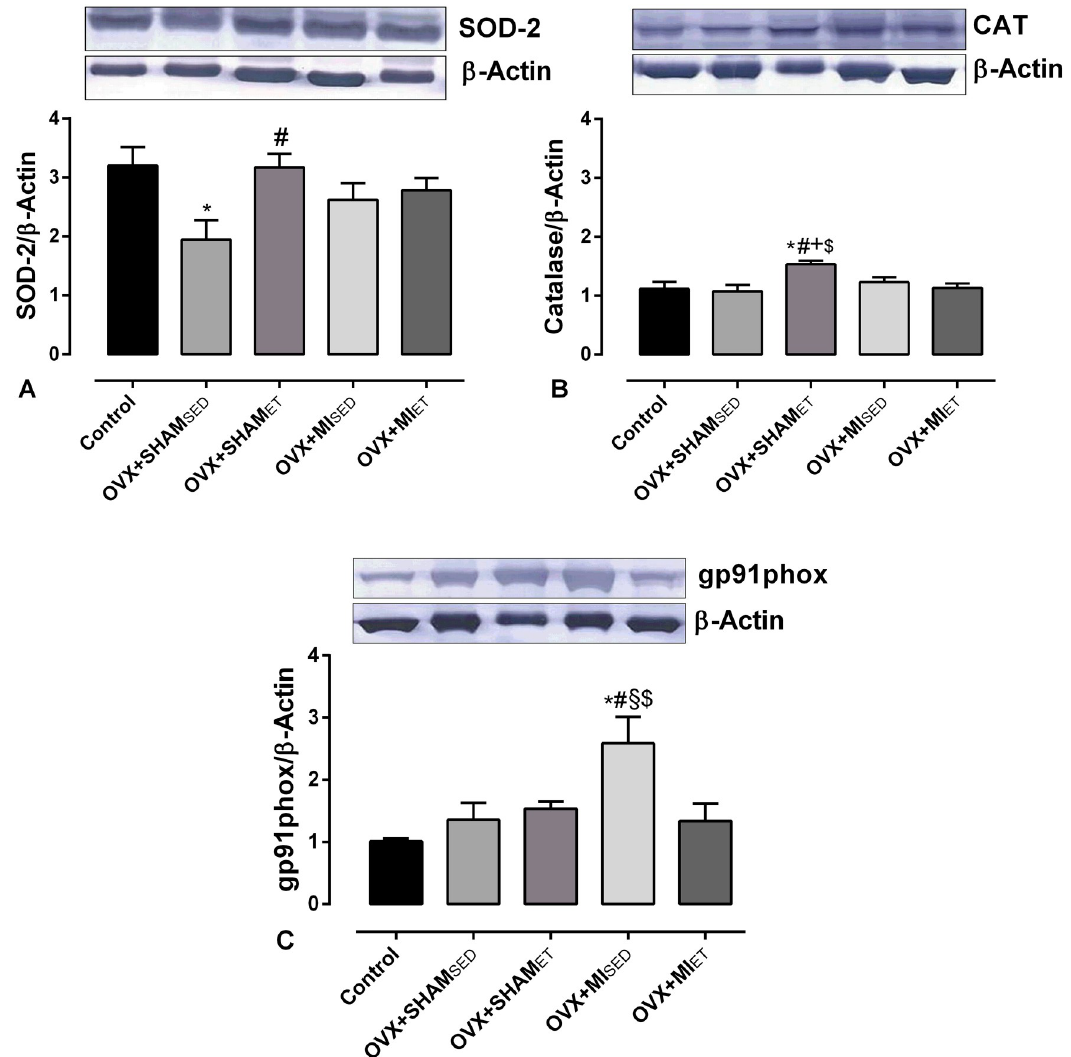
Fig 4. Protein expression of the enzymes SOD-2, Catalase, and gp91phox. Data are expressed as mean ± standard error of the mean (SEM). One-way ANOVA followed by the Fisher post-hoc test for multiple comparisons. � p < 0.05 vs Control; # p < 0.05